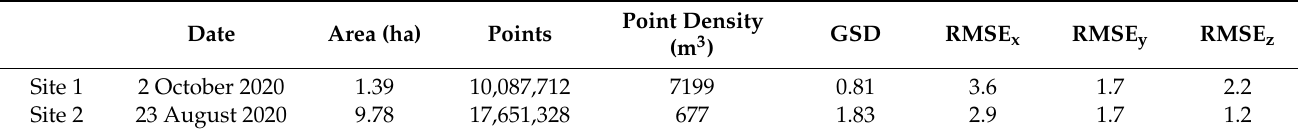
Table 2. Results of the SfM processing from the Pix4D software. In this table, RMSE x,y,z are the accuracy assessments calculated from points not used in the georeferencing of the point cloud. GSD and RMSE numbers are in cm.